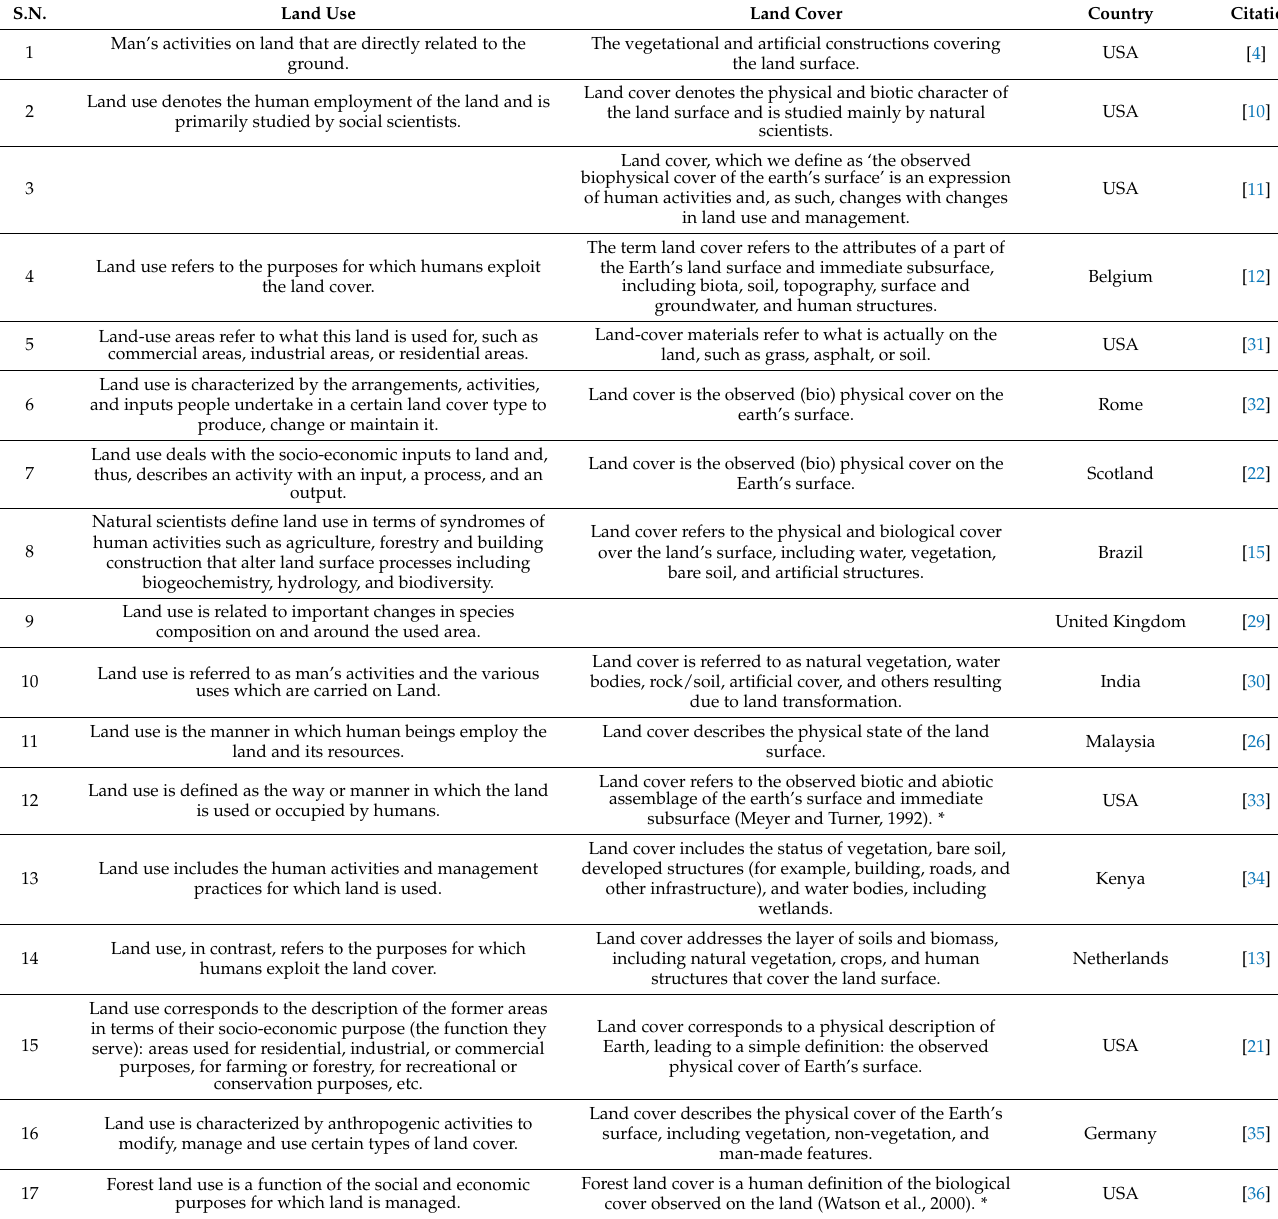
Table 2. Definitions for “ Land use ” and “ Land cover ” from various